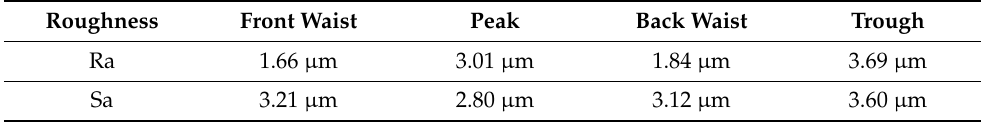
Figure 14. Three-dimensional profile of Mg cross-section: ( a – c ) front waist; ( d – f ) peak; ( g – i ) back waist; ( j – l ) trough. Table 4. Roughness statistics of Mg matrix fracture